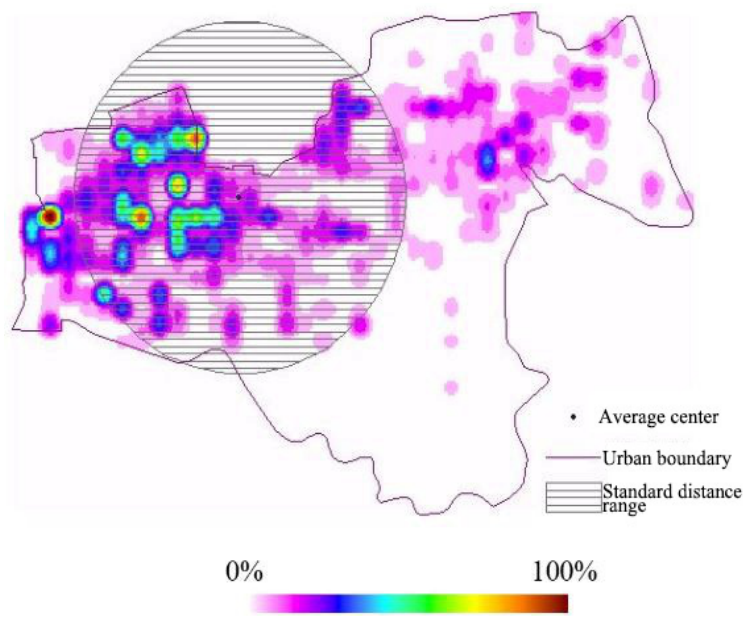
Figure 8. Distribution of pending points and demand points. For the Lixia area kernel density analysis, the population density distribution map is shown in Figure 9.